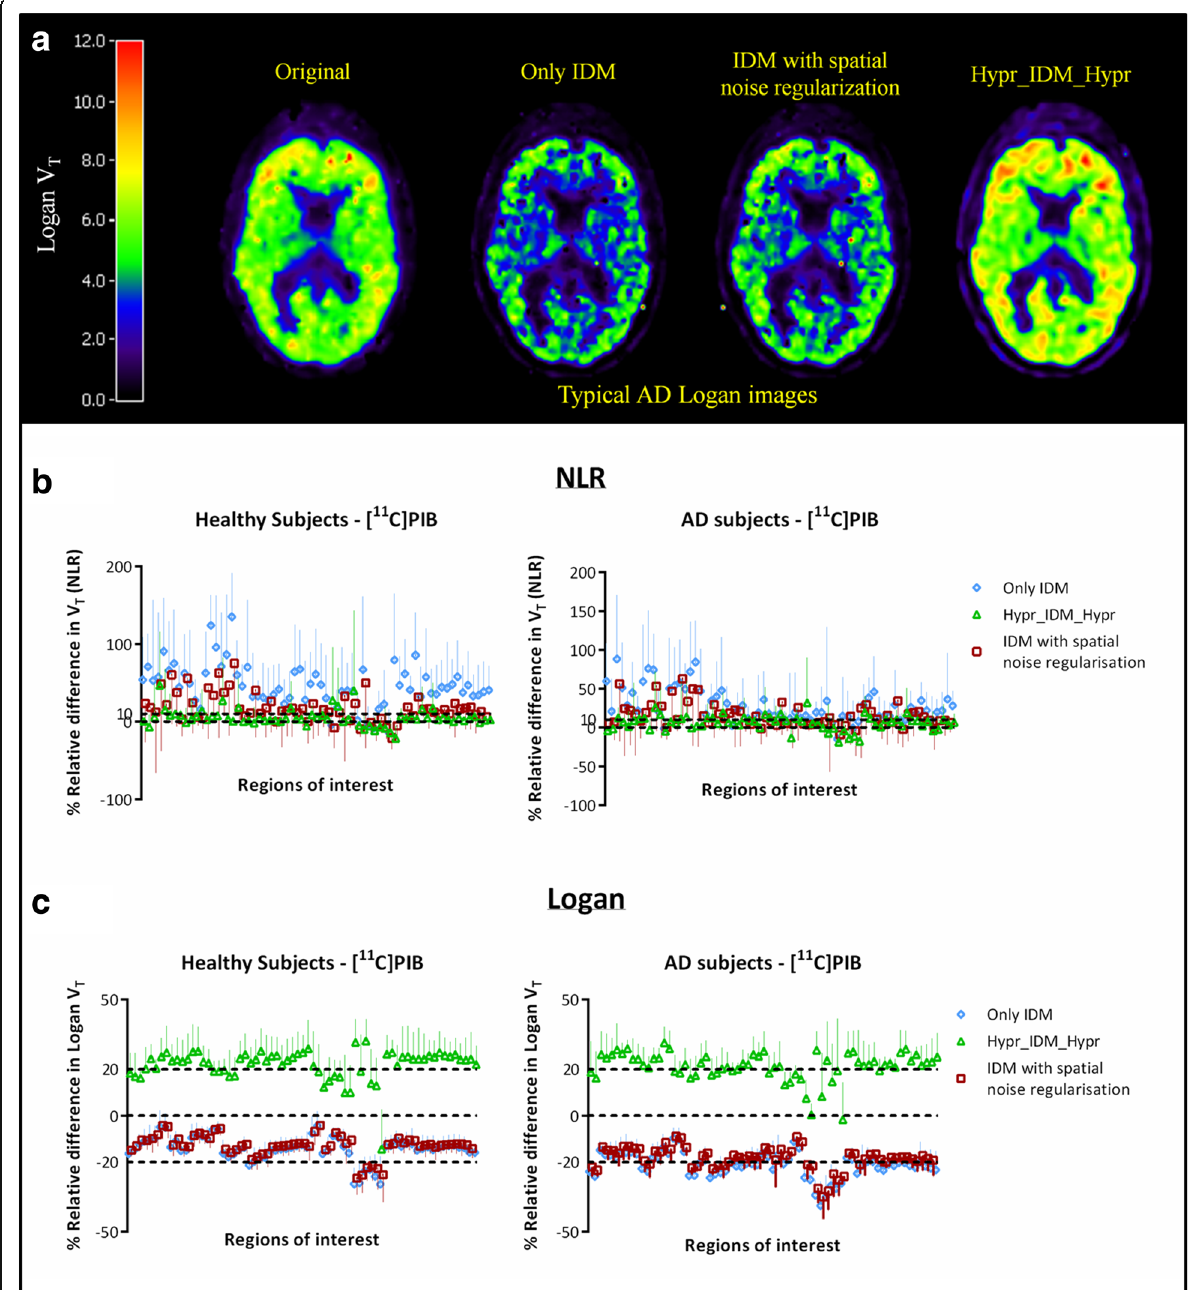
Fig. 6 a Typical [ 11 C]PIB V T images for an AD subject. Quantitative effects of applying IDM on V T values obtained using b NLR and c Logan analyses for both healthy subjects and AD